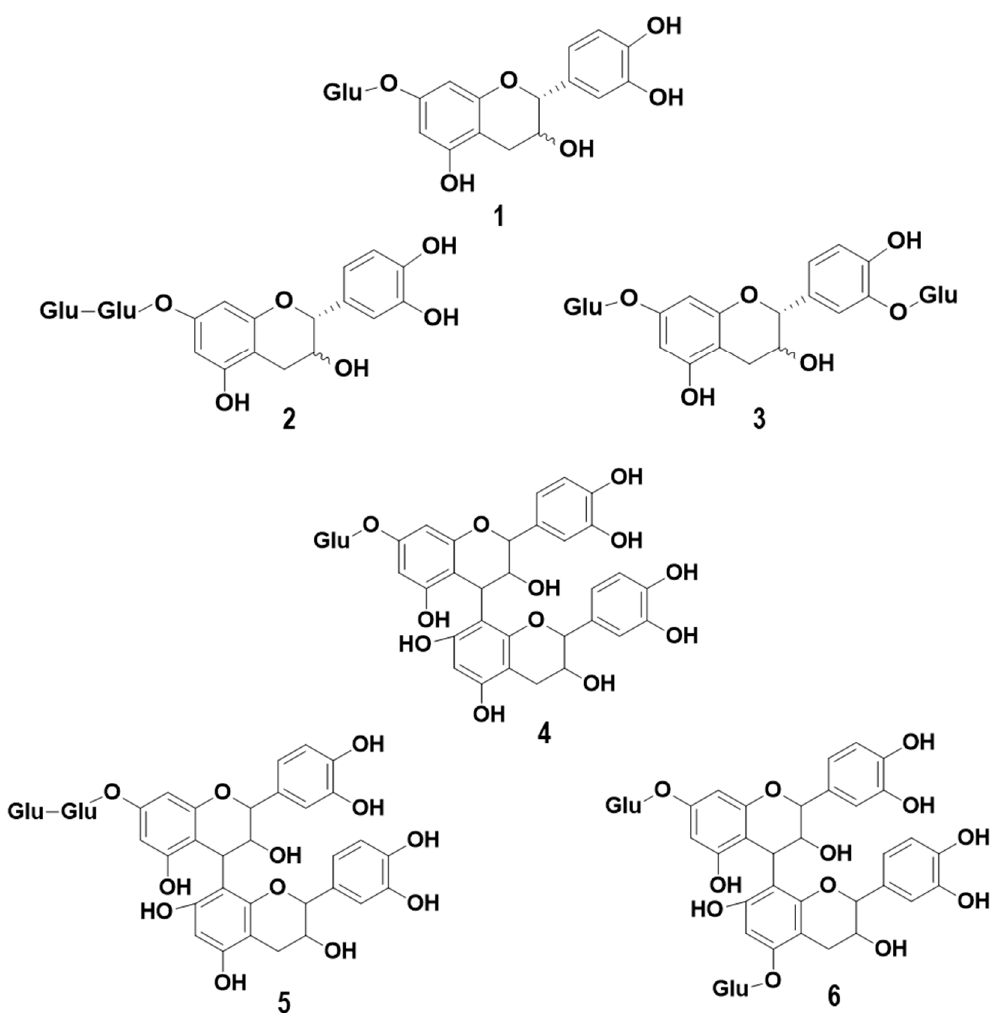
Figure 1. Examples of monomeric (epi) catechin mono glucoside ( 1 ), monomeric (epi) catechin diglycosides ( 2 and 3 ), dimeric (epi) catechin monoglycoside ( 4 ), and dimeric (epi) catechin diglycosides ( 5 and 6 ).